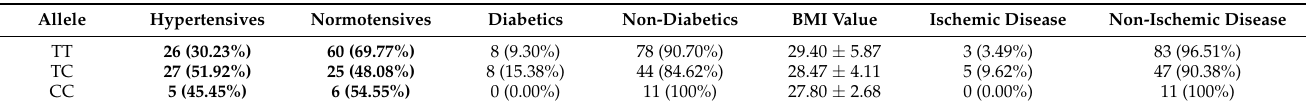
Table 7. The prevalence of arterial hypertension in the rs2853669 SNPs of the TERT gene. Statistically significant differences are indicated by boldface ( p < 0.05).